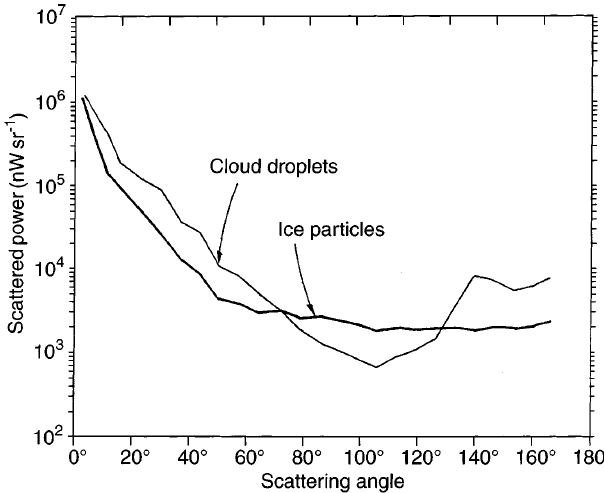
Fig. 4. Examples of scattering phase function measured by the polar nephelometer in the open wind tunnel located at the top of the Puy de Doˆ me mountain for two typical cloudy conditions: (1) water droplets and (2) ice crystal particles